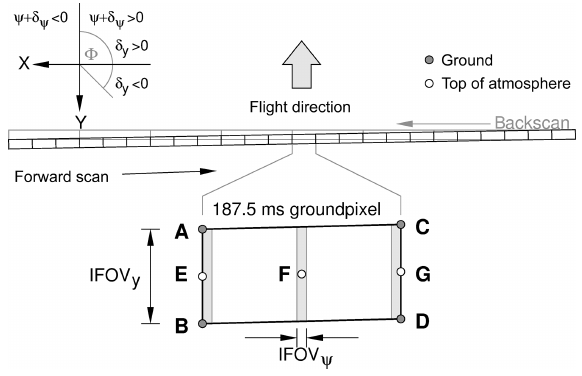
Figure 7. GOME-2 ground pixel orientation relative to the scan and the flight direction.